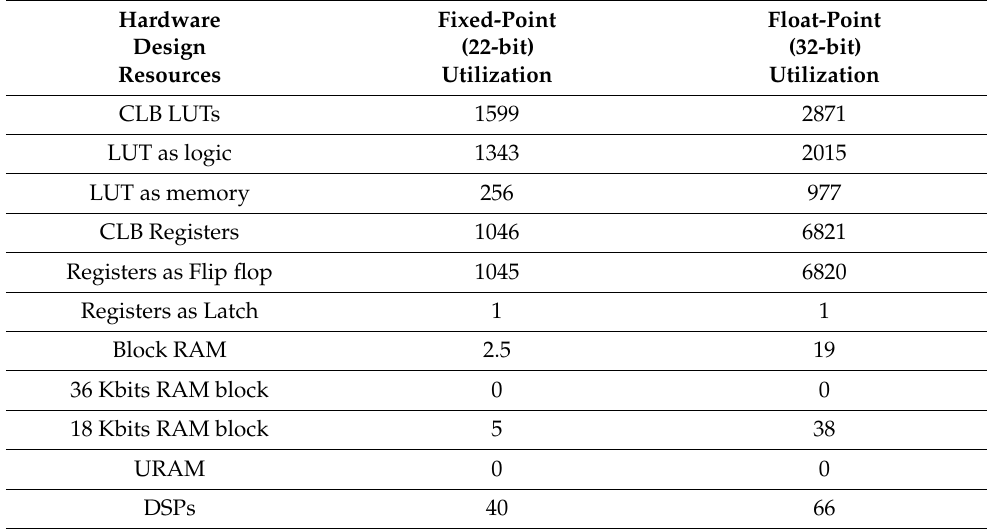
Table 4. Hardware design resources of the fixed-point (22-bit) and float-point (32-bit)